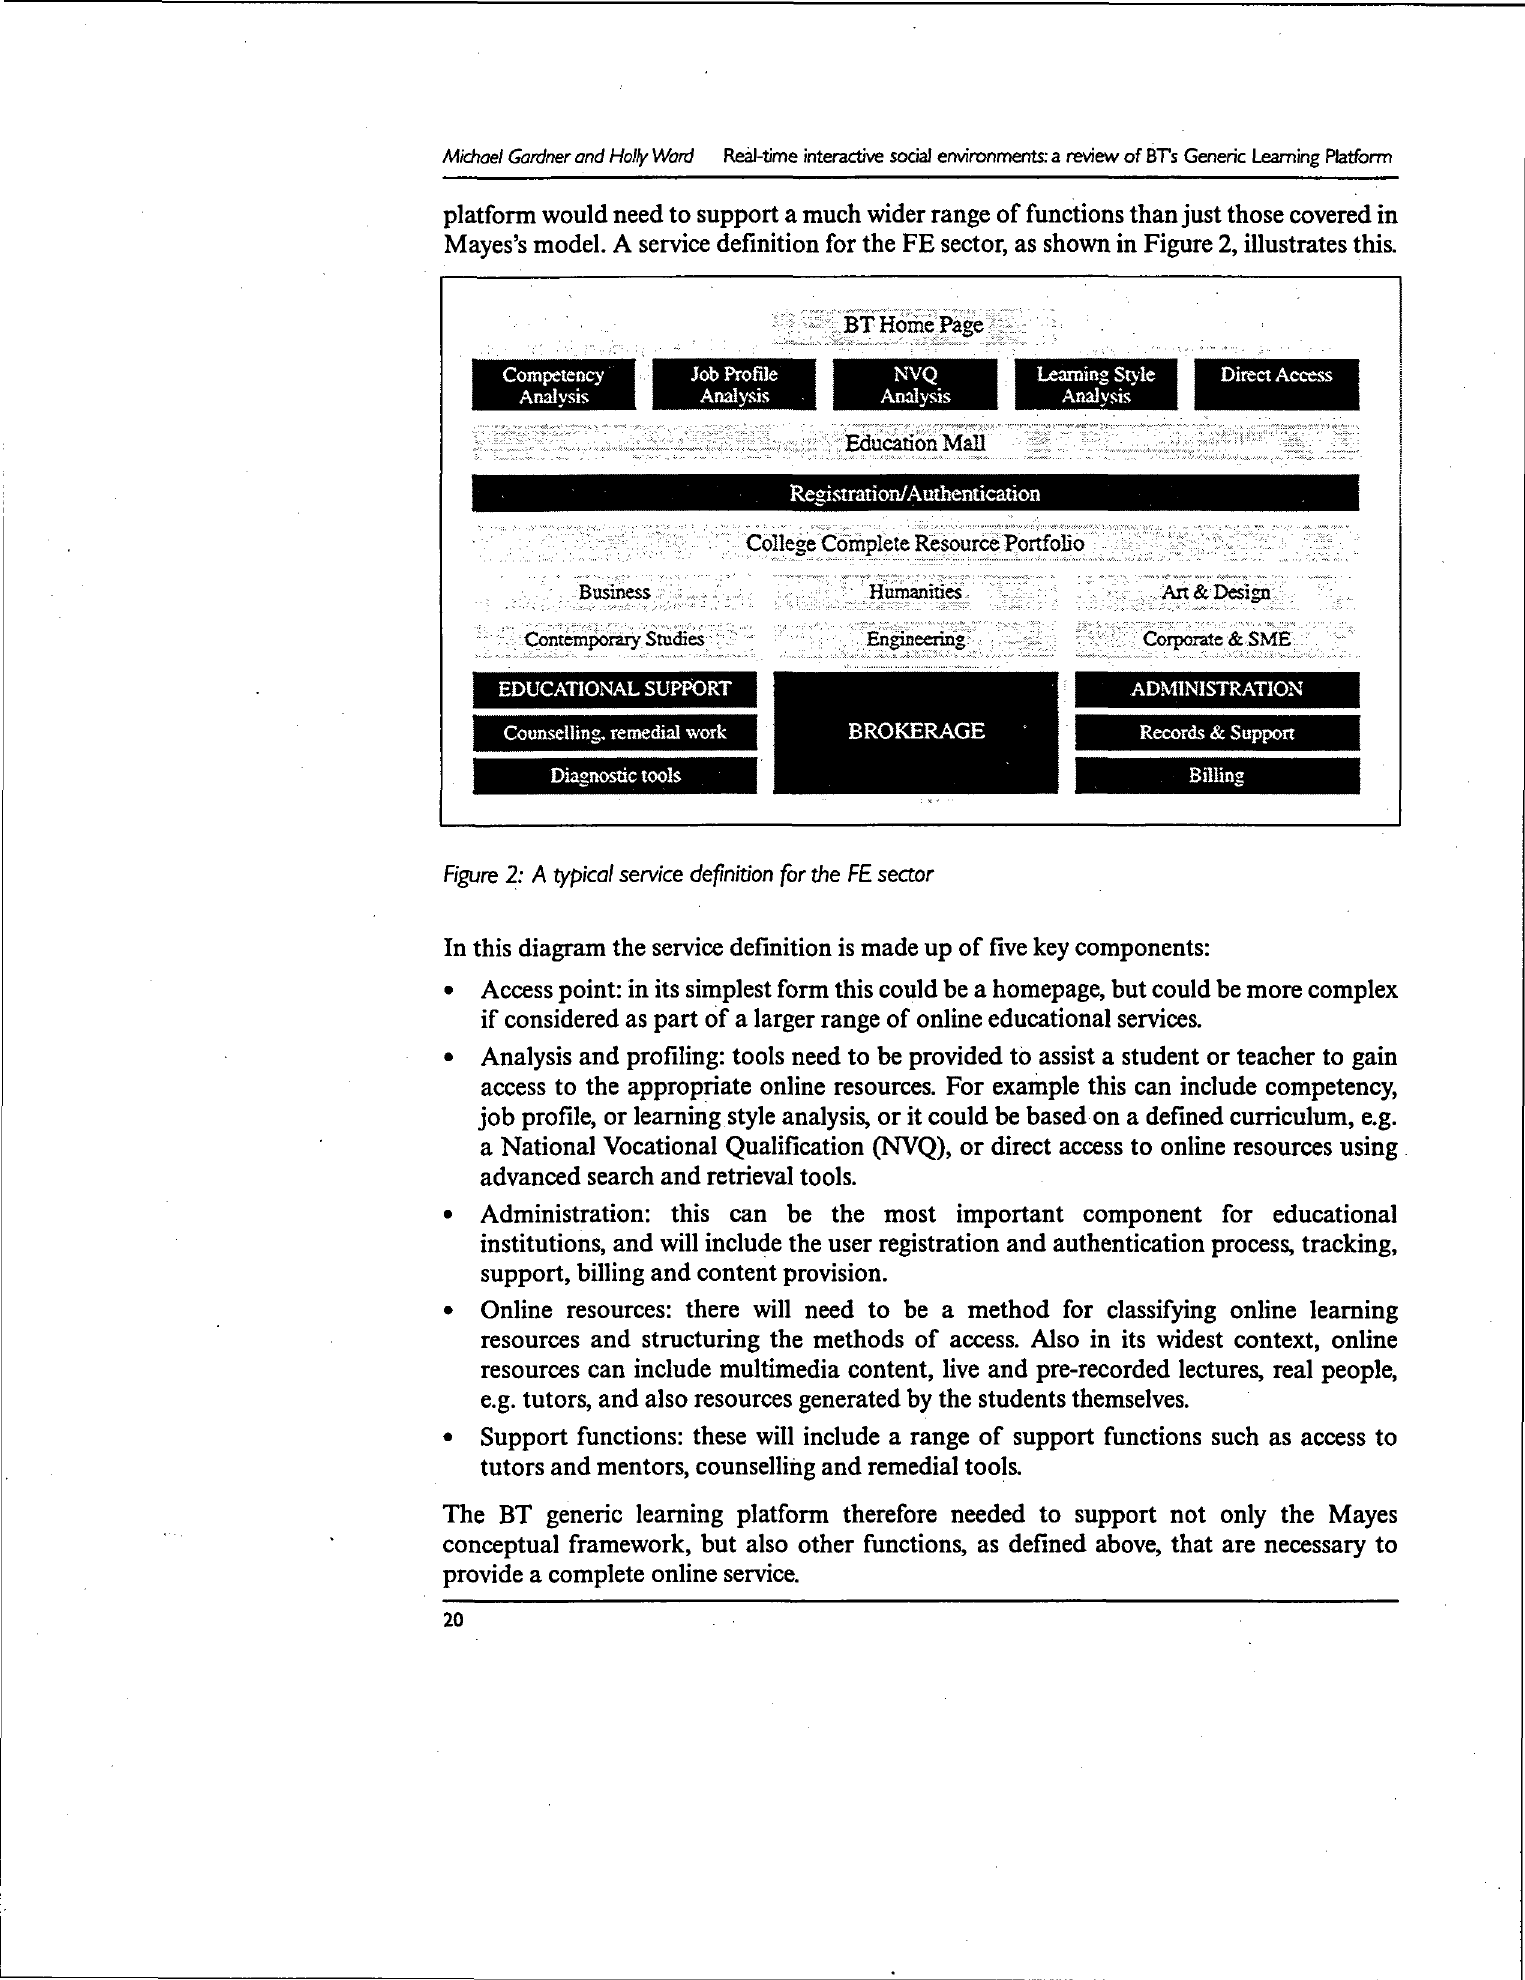
Figure 2: A typical service definition for the FE